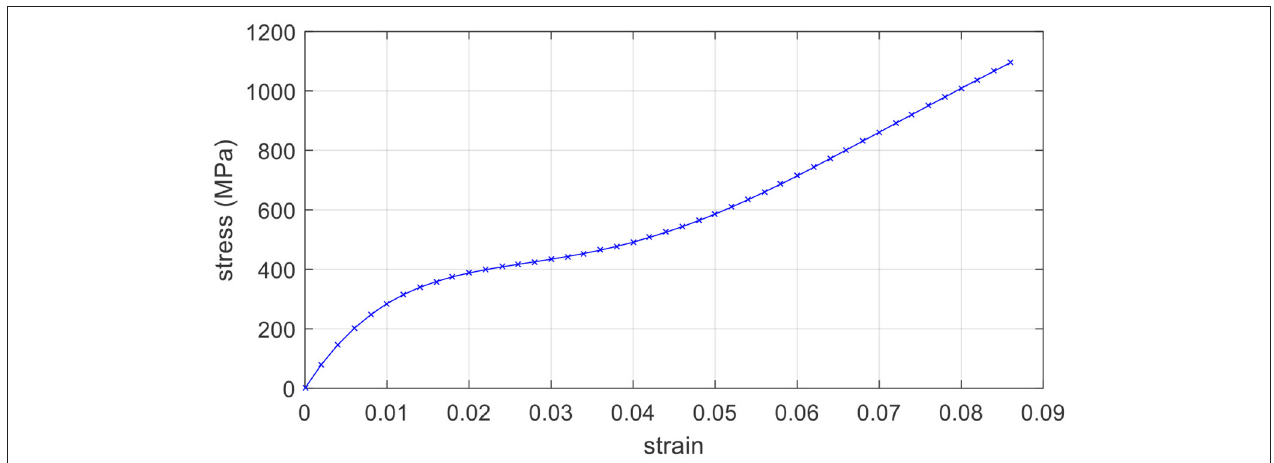
Frontiers in Built Environment |